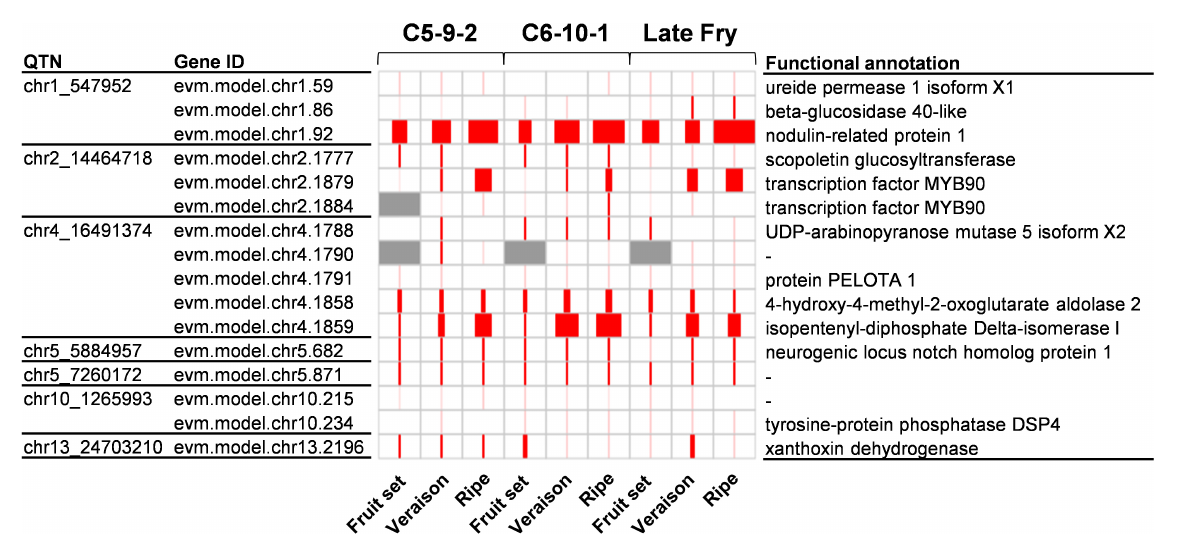
FIGURE5 Expression of candidate genes identified by chr4_16491374. The QTN name and corresponding gene ID are listed on the left side of the panel. The functional annotation information is listed on the right side of the panel. In the panel, the size of red squares represents the TPM value of the corresponding gene. The max TPM was